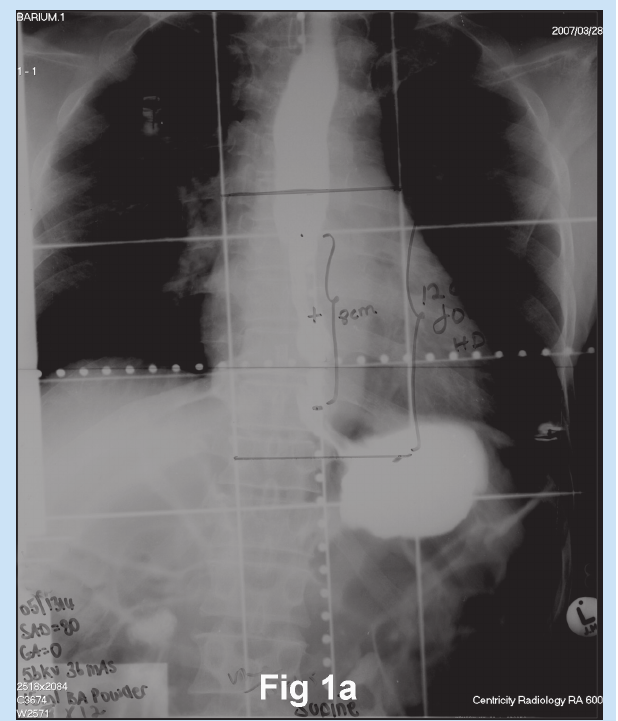
Fig. 1a. Simulator film with barium as a contrast.